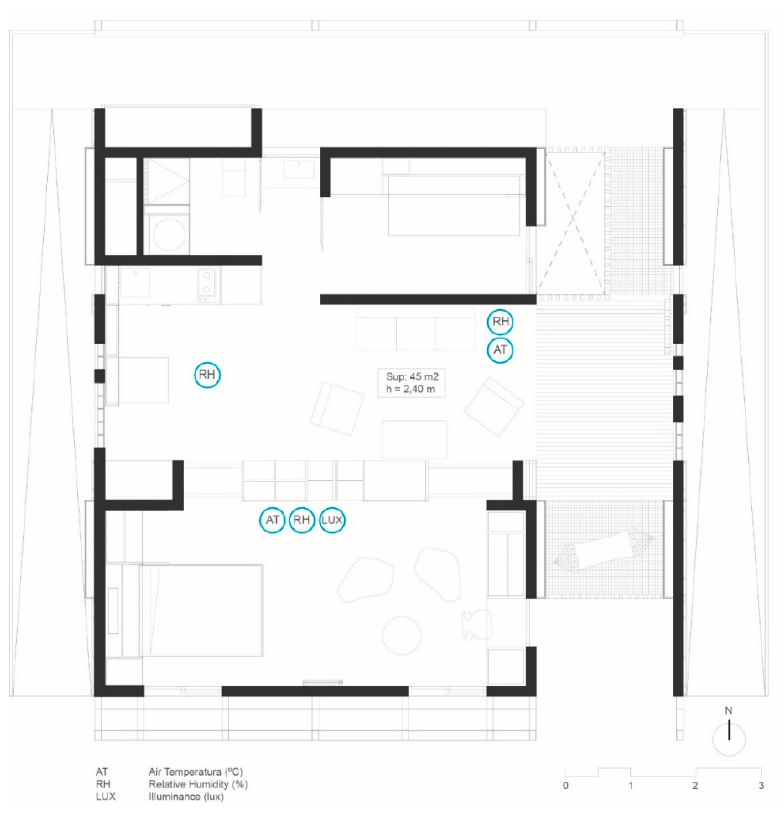
Figure 21. Prototype plant and measurement points.